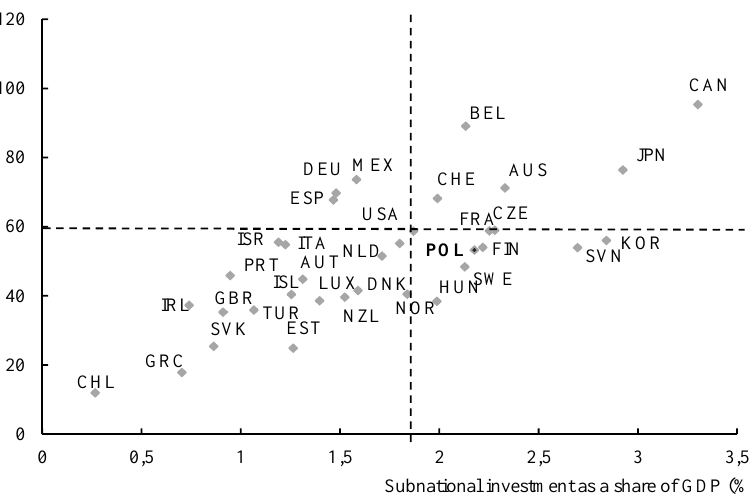
Figure 2. Subnational investment as a share of public investment and GDP in OECD countries in 2014